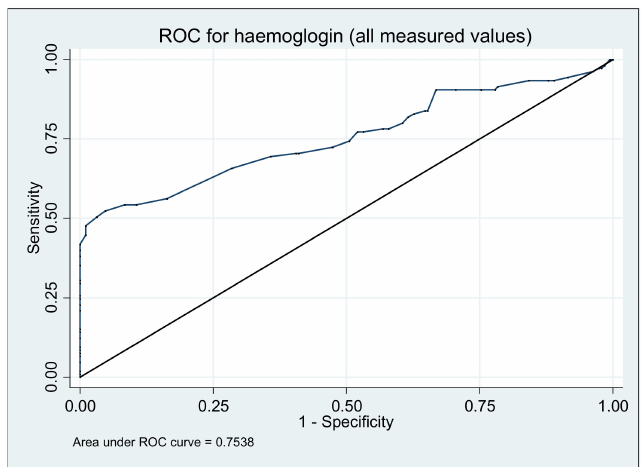
Figure 3. Area under the receiver operating characteristic (ROC) curve to predict ulcerative colitis relapse using hemoglobin concentration measurement during 12